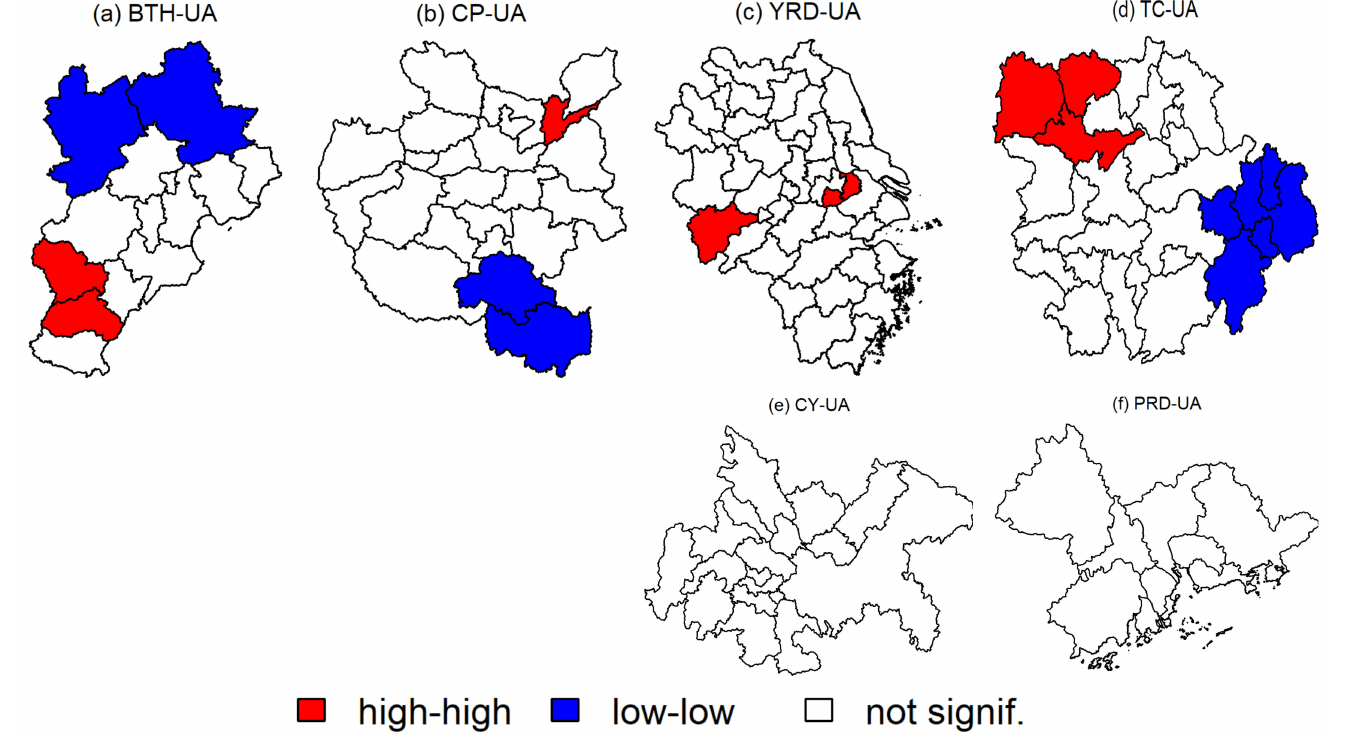
Figure 6. Spatial patterns of PM 2.5 in the ( a ) BTH-UA, ( b ) CP-UA, ( c ) YRD-UA, ( d ) TC-UA, ( e ) CY-UA and ( f ) PRD-UA over the period of